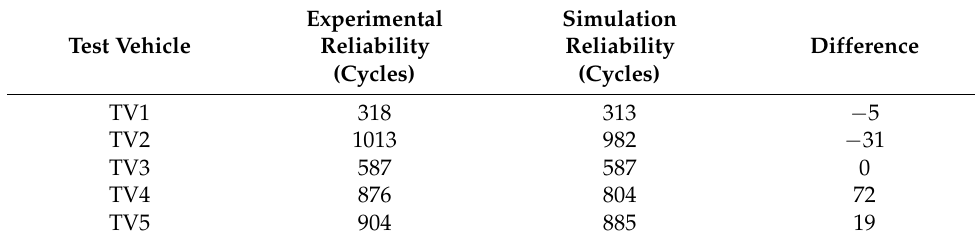
Table 5. WLP finite element results for five test